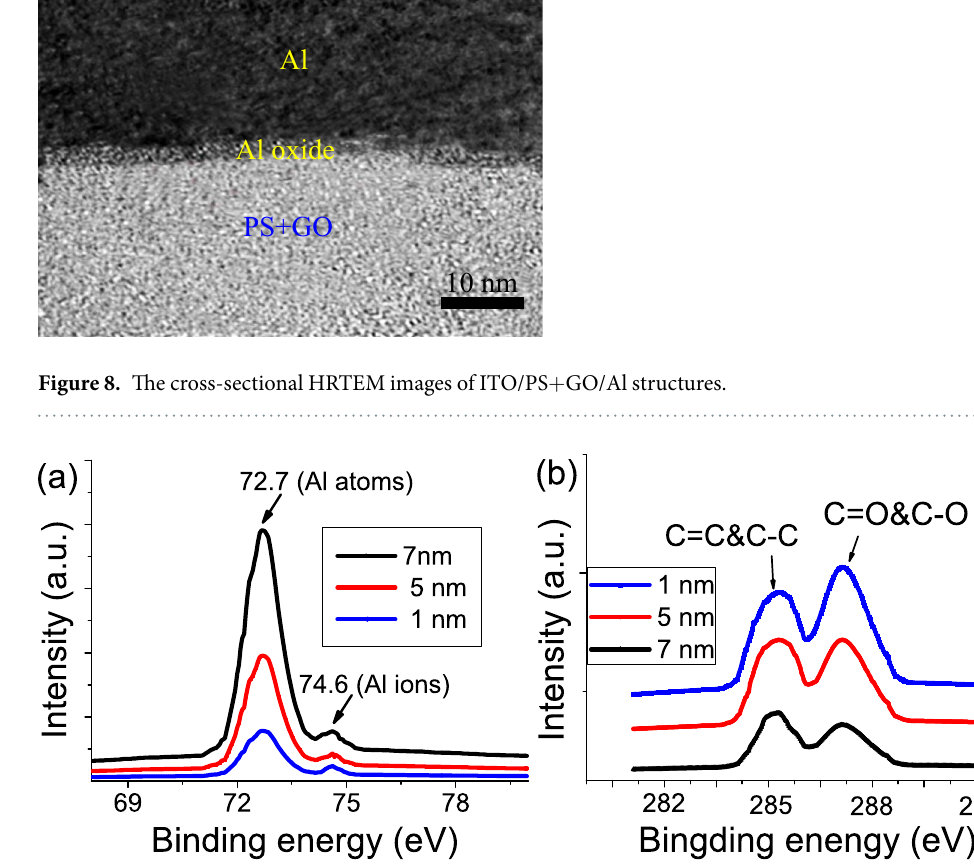
Figure 9. ( a ) The XPS spectrum of Al 2 p ; ( b ) The XPS spectrum of C 1 s